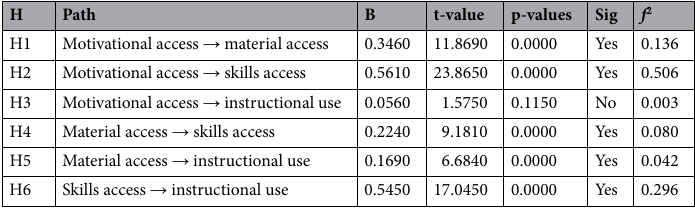
Table 5. significant tests and effect sizes ( f 2